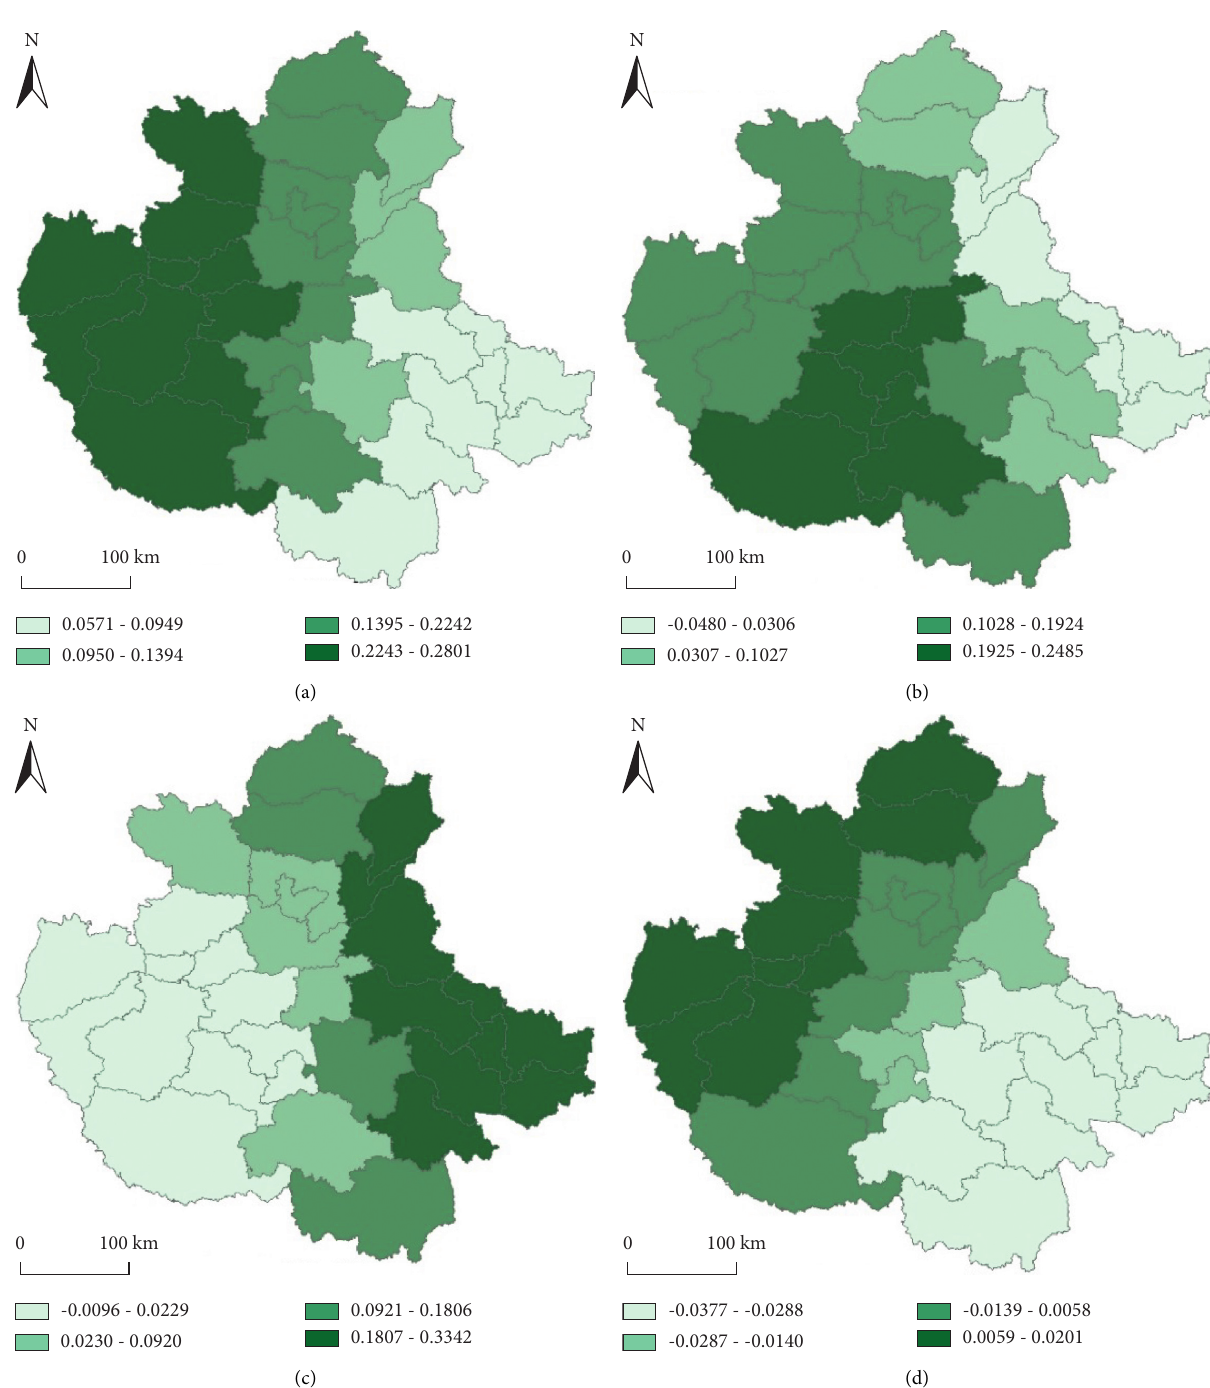
Figure 5: Spatial distribution of regression coefficients of each influencing factor.